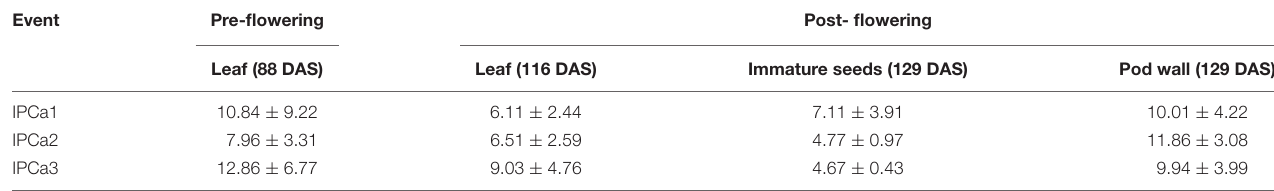
TABLE 2 | Quantification of Cry1Aabc protein at pre flowering and post-flowering stage (T 4 generation) of different chickpea